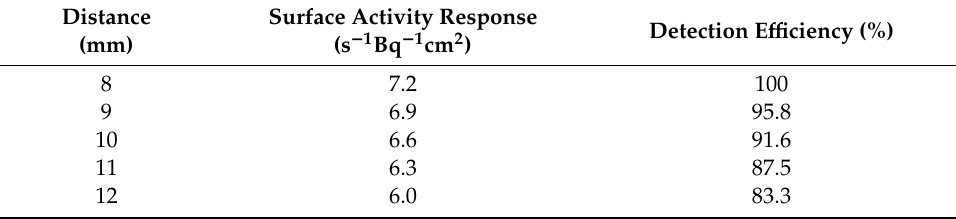
Table 5. The source of β particle surface activity response test at di ff erence